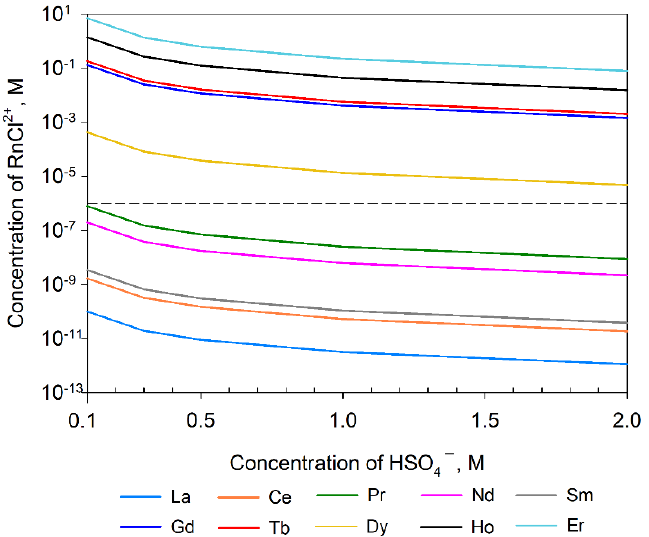
Figure 7. Concentrations of RnCl 2+ of the ten different REEs in equilibrium with Rn 2 (SO 4 ) 3 at pH 1 with HCl.